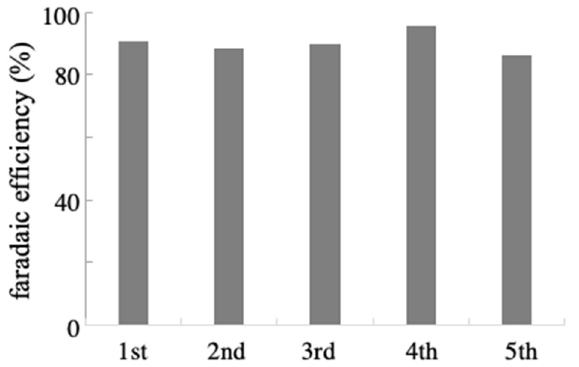
Figure 5. FE for L-glutamic acid production obtained at a single NPG electrode from five sequential experiments. Electrolysis was conducted on 50 mM of α -ketoglutaric acid in the presence of NH 2 OH at − 0.01 V for 30 min.